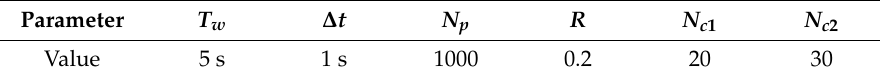
Table 1. Parameters setting in pigeon inspired optimization (PIO) algorithm.